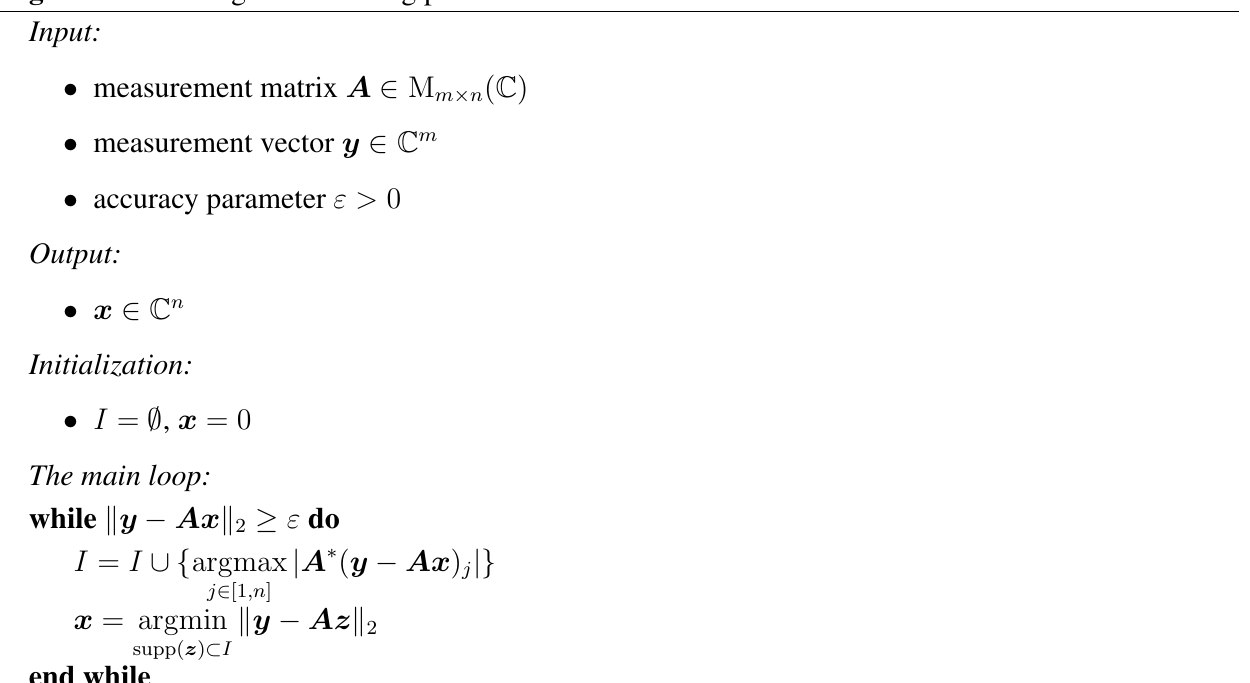
Algorithm 1 Orthogonal matching